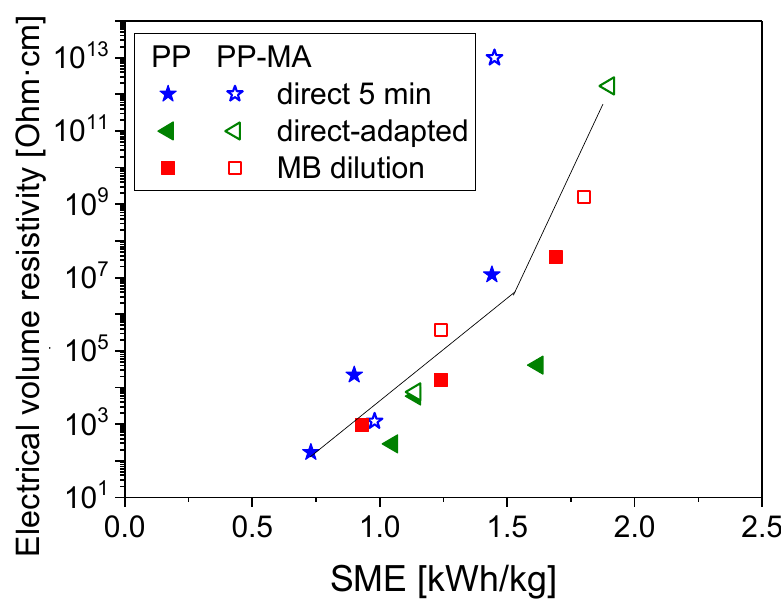
Figure 6. Electrical volume resistivity vs. SME for PP/2 wt % MWCNT, lines are only for guiding the eyes.